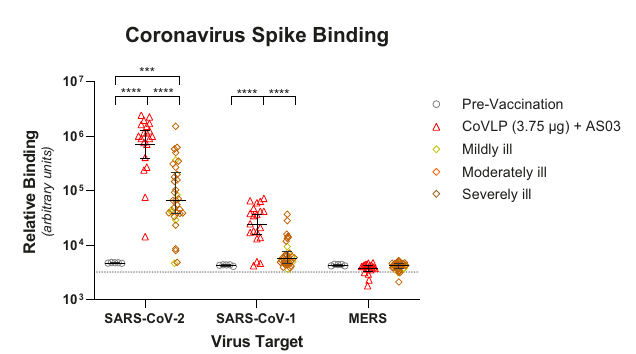
Fig. 2 | Binding antibody cross-reactivity to betacoronaviruses. Binding of serum antibodies from pre-vaccinated subjects ( n =5) and from D42 of subjects vaccinated with 3.75 µ g CoVLP adjuvanted with AS03 ( n =20) to protein S from SARS-CoV-2, SARS-CoV-1, and MERS (geometric mean and 95% CI) were quanti fi ed using the VaxArray platform from InDevR, Inc. Convalescent sera or plasma col- lected at least 14 days after a positive diagnosis of COVID-19 (RT-PCR) from indi- viduals whose illness was classi fi ed as mild, moderate, or severe/critical ( n =35) were analyzed concurrently. Dotted line indicates mean background control values.Signi fi cantdifferencesbetweenseraareindicatedbyasterisks(*** p <0.001; **** p <0.0001; One-way analysis of variance on log-transformed data, GraphPad Prism,